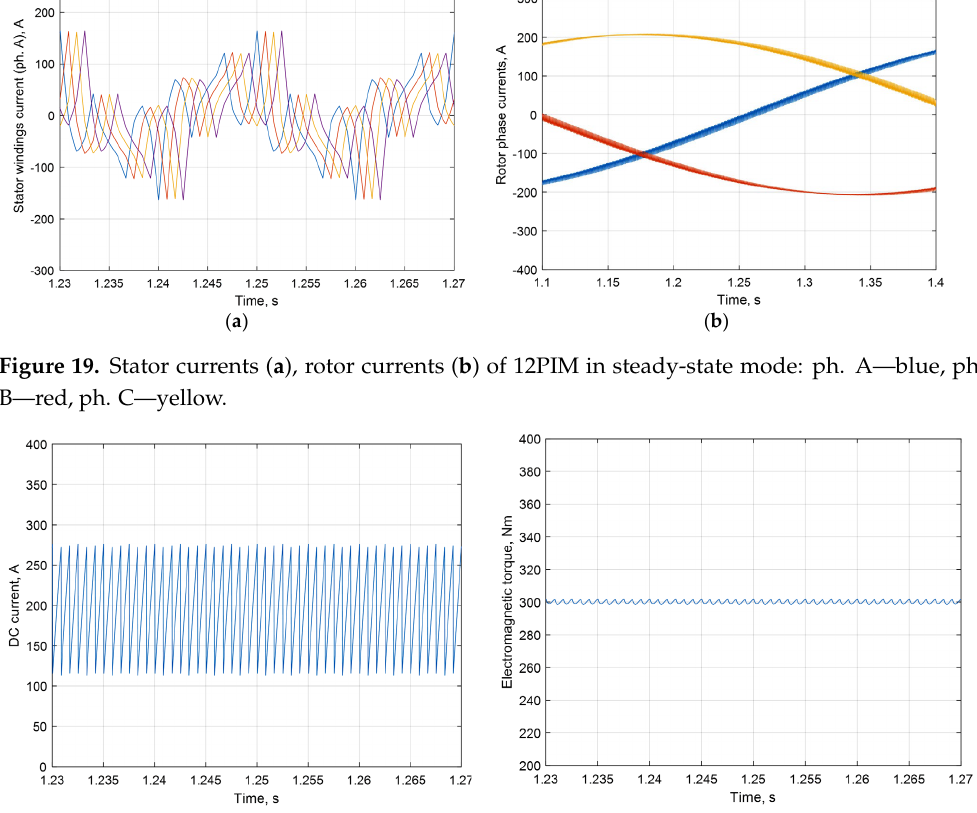
Figure 20. DC-link current ( a ), electromagnetic torque ( b ) of 12PIM in steady-state mode.